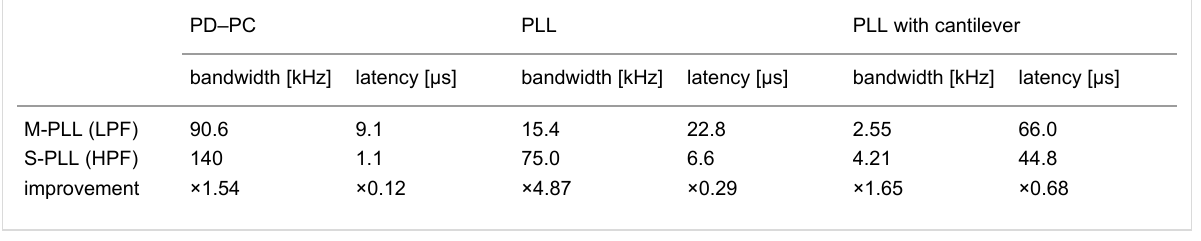
Table 1: Bandwidths and latencies of the developed PD–PC unit, PLL, and PLL with a cantilever ( f 0 = 150 kHz, NCH, Nanoworld).